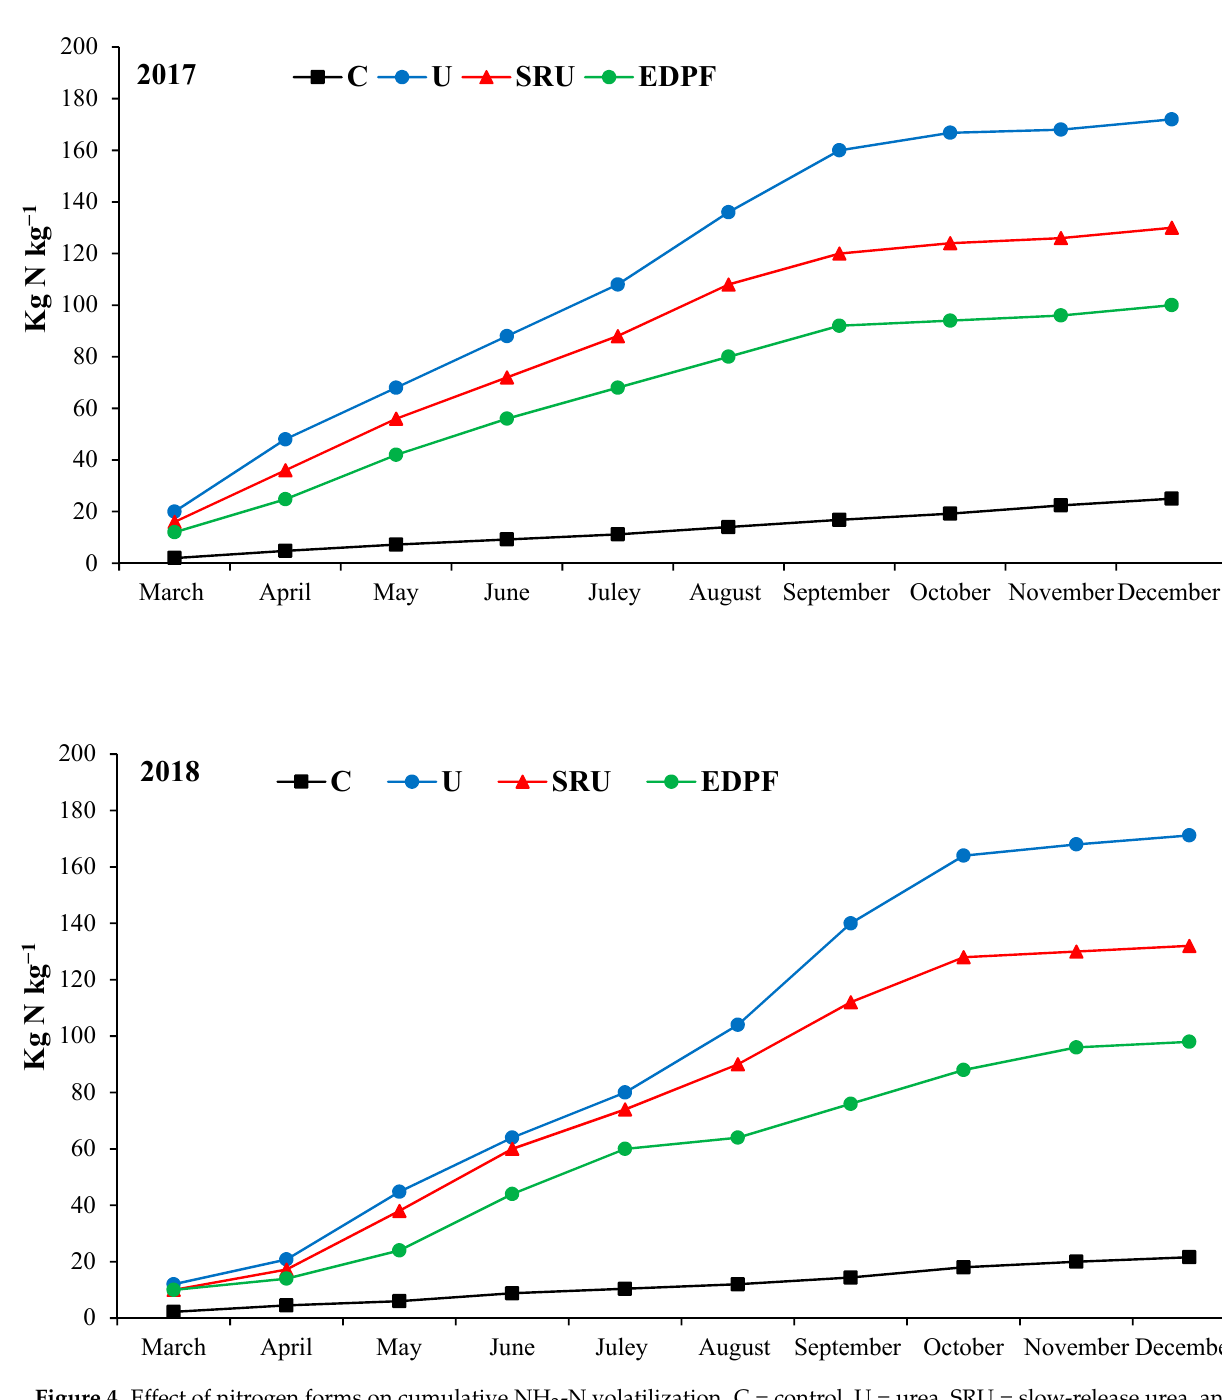
Figure 4. Effect of nitrogen forms on cumulative NH 3 -N volatilization. C = control, U = urea, SRU = slow-release urea, and EDPF = expired dairy products fertilizer.